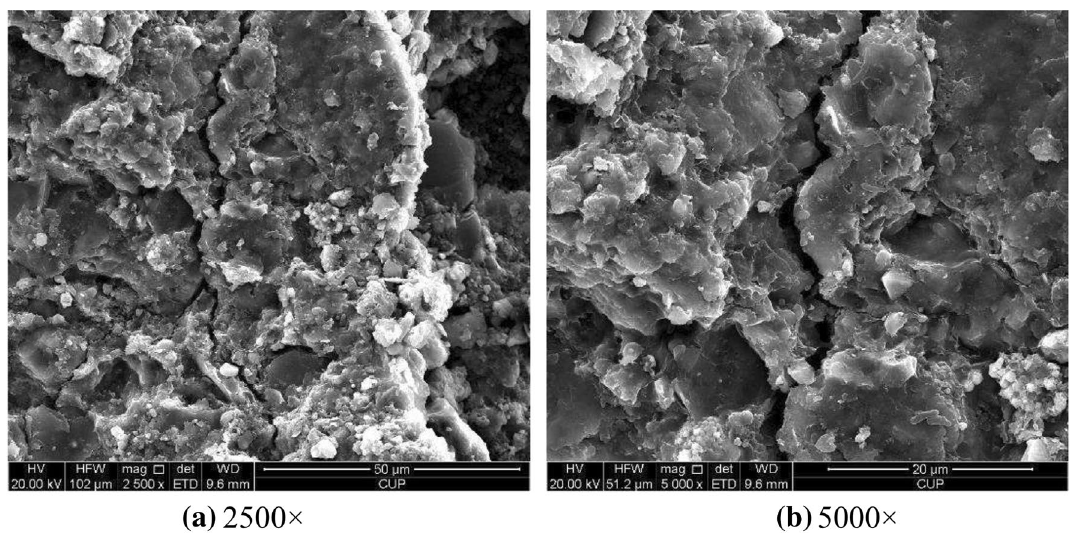
Fig. 16 SEM images of water-saturated shale after LN